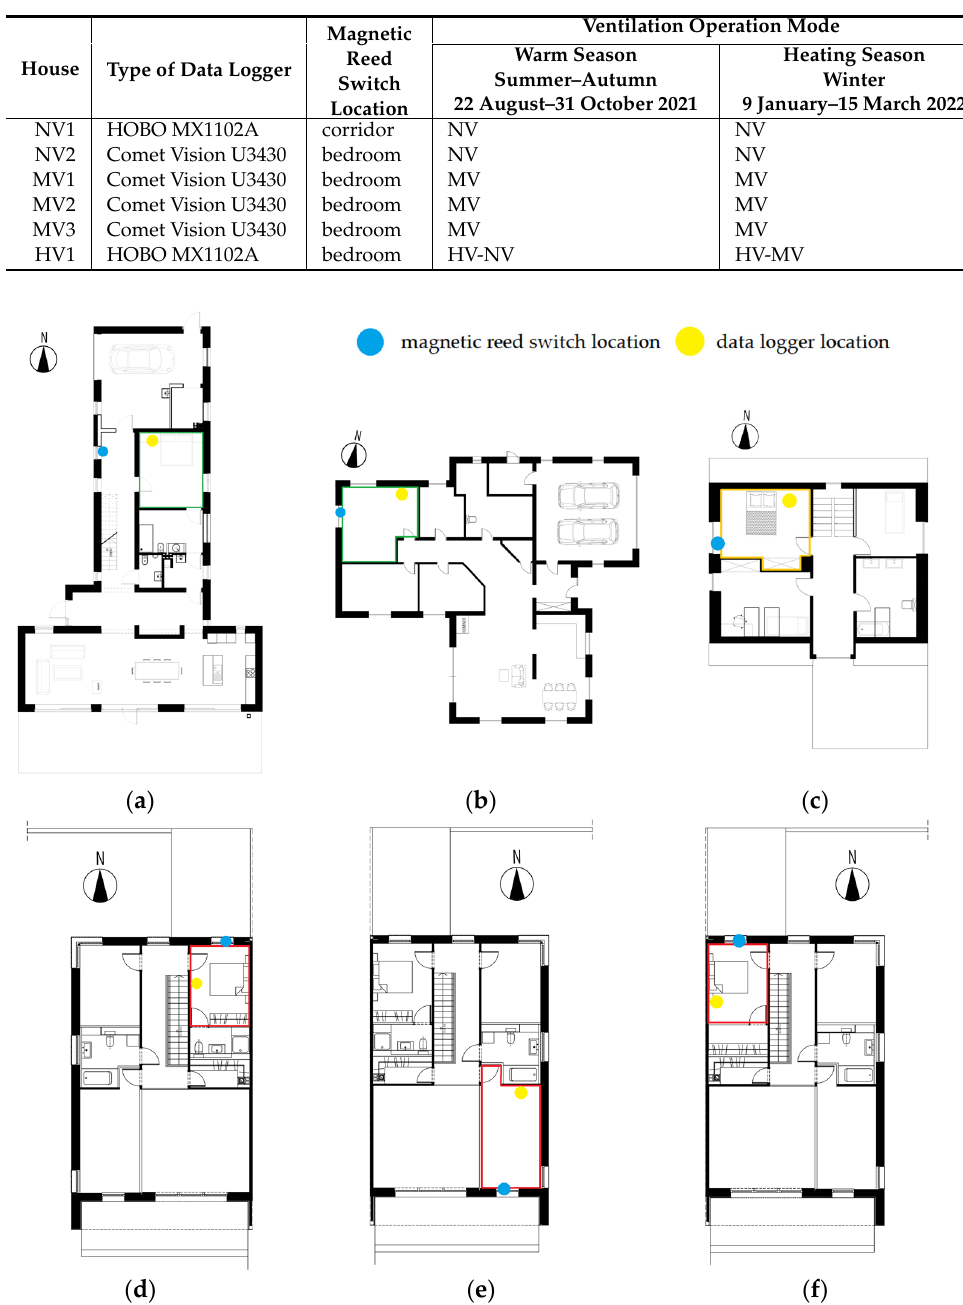
Table 3. Measuring equipment and operating mode of the ventilation system in buildings.